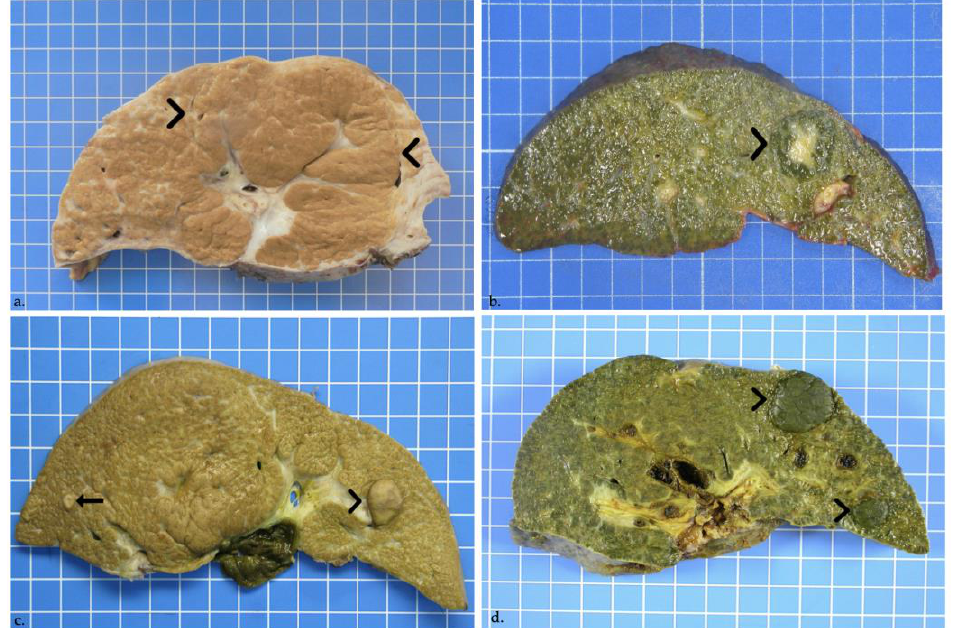
Table 2. Histo-pathological characteristics of nodules identified in liver explants . * One nodule can overlap multiple liver segments. ** Largest diameter for every nodule, median (range) diameter for every nodule type . KPE, Kasai hepatoportoenterostomy; LT, liver transplantation.